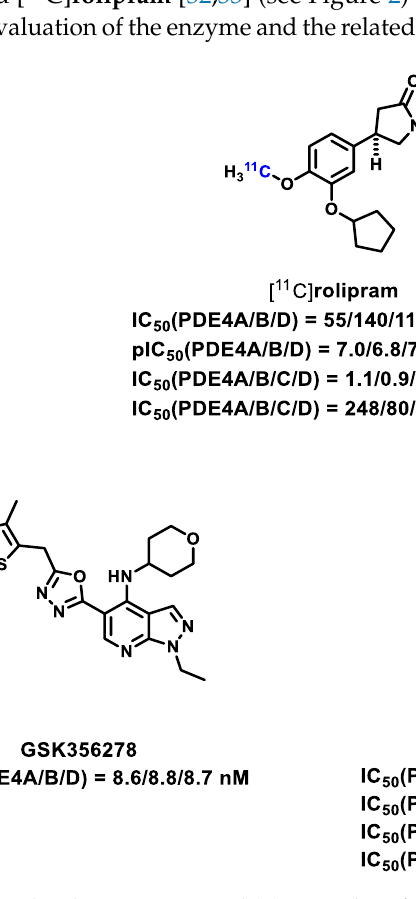
Figure 2. Molecular structures and (p)IC 50 values for the PDE4 isoforms of ([ 11 C]) rolipram [38–41] and the PDE4 inhibitors GSK356278 [41] and roflumilast